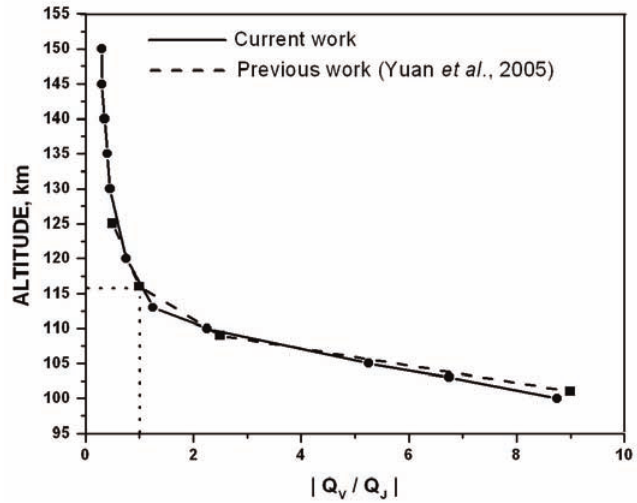
Figure 3. Variation of the ratio of the viscous heating rate to the Joule heating rate with altitude. The continuous curve connecting the filled circles represents the data from the present study, while the dashed curve joining the filled squares represents the data from the earlier study of Yuan et al.